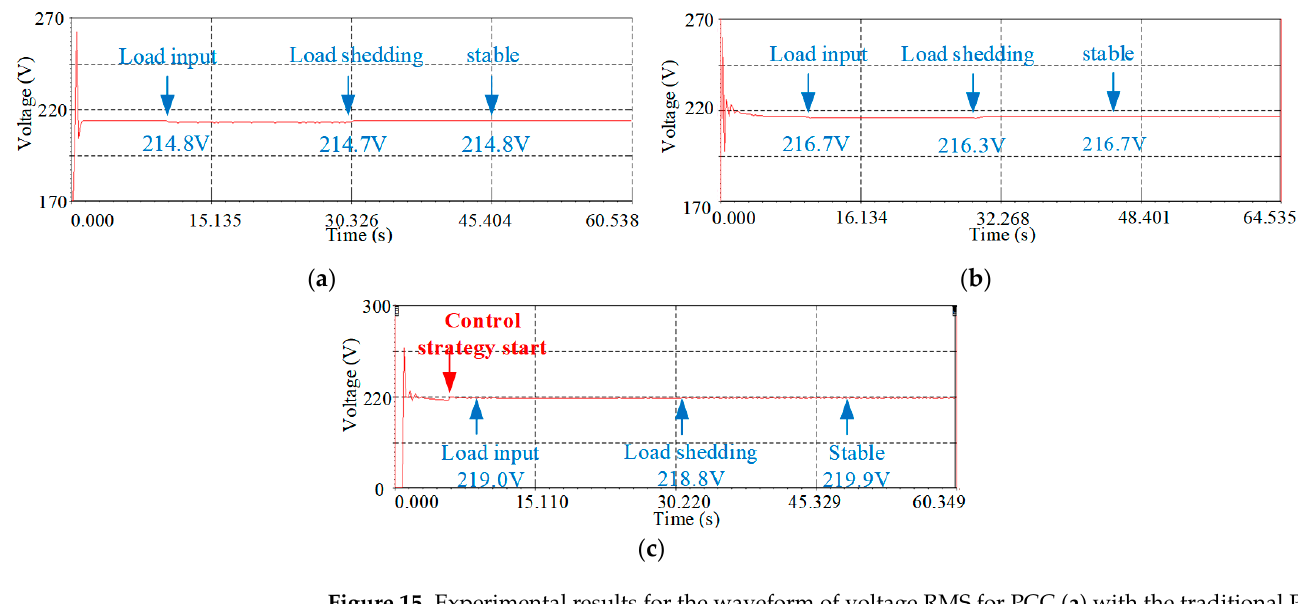
Figure 15. Experimental results for the waveform of voltage RMS for PCC ( a ) with the traditional PI control strategy; ( b ) with the harmonic and imbalance voltage suppression of multi-inverter parallel VSG; ( c ) with the harmonic and imbalance voltage suppression of multi-inverter parallel VSG adding a secondary control strategy.